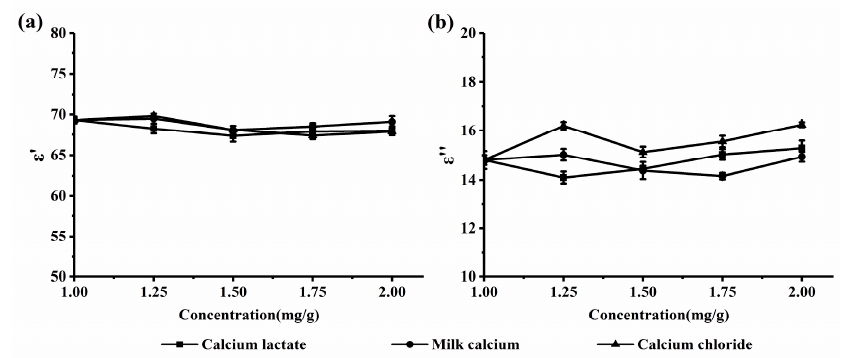
Figure 2. ( a ) The dielectric constant ε′ and ( b ) dielectric loss factor ε′′ of the calcium-fortified milk systems.